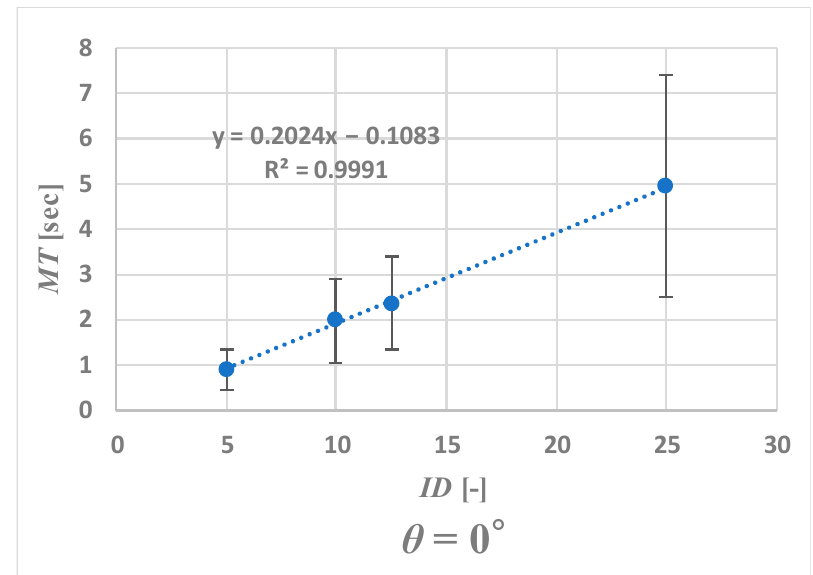
Figure 4. Relationship between ID and MT at θ = 0 degrees.